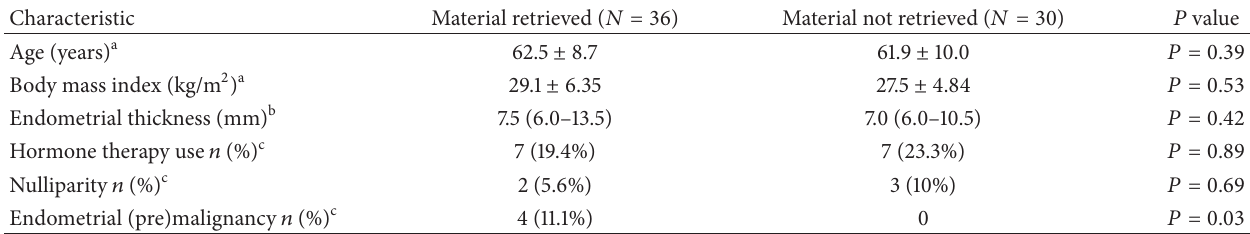
Table 3: Characteristics of women with a nondiagnostic sample, retrieved samples versus not retrieved